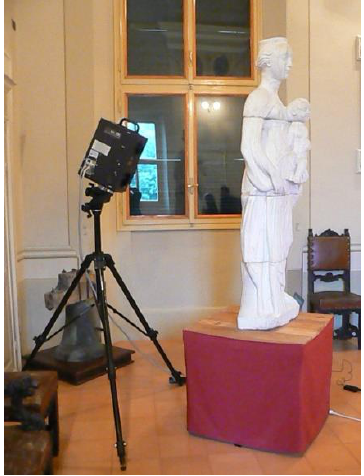
Figure 15. Statue Madonna with the Child, with the laser scanner in position.